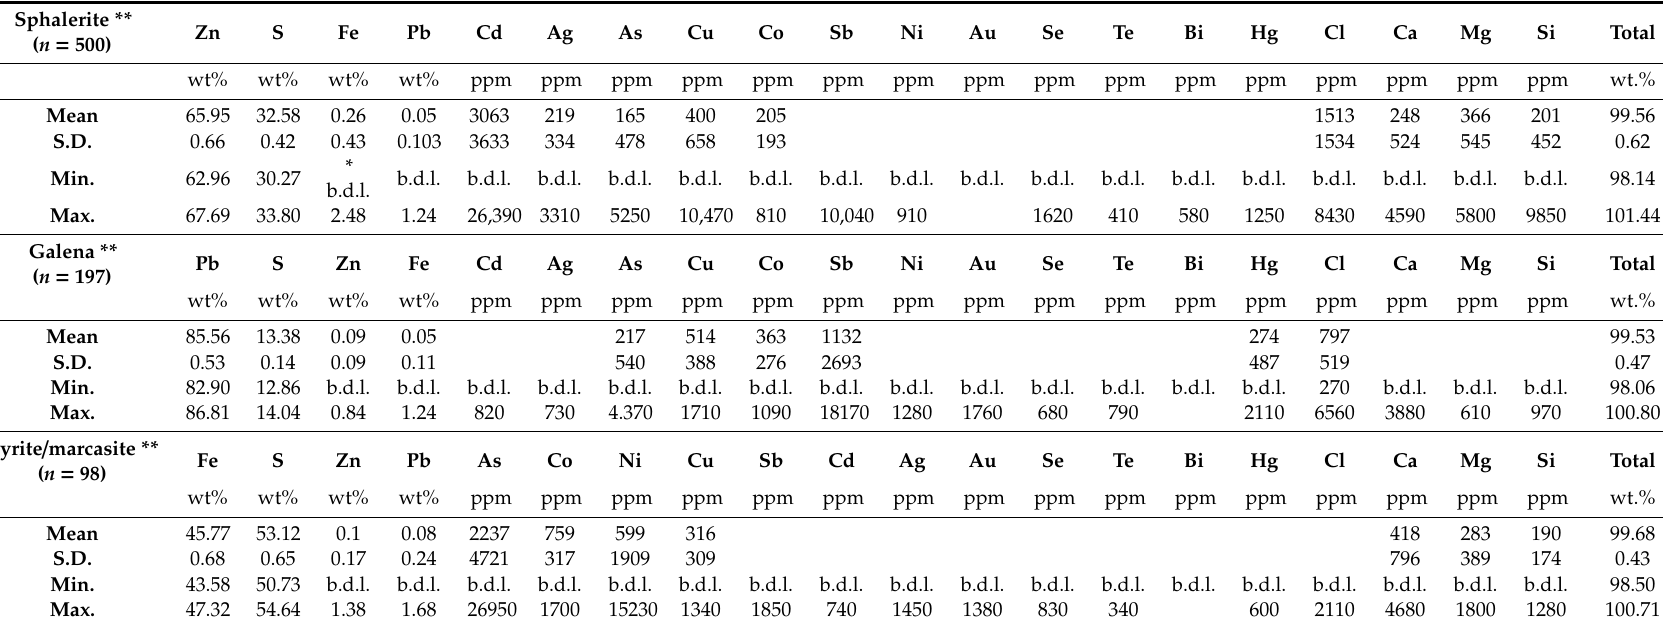
Table 4. Average EPMA analyses of sphalerite, galena, and pyrite / marcasite from the Zn-Pb (MVT) deposits in